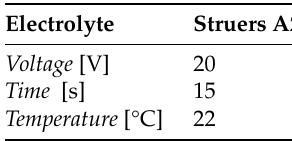
Table 3. Parameters used during the